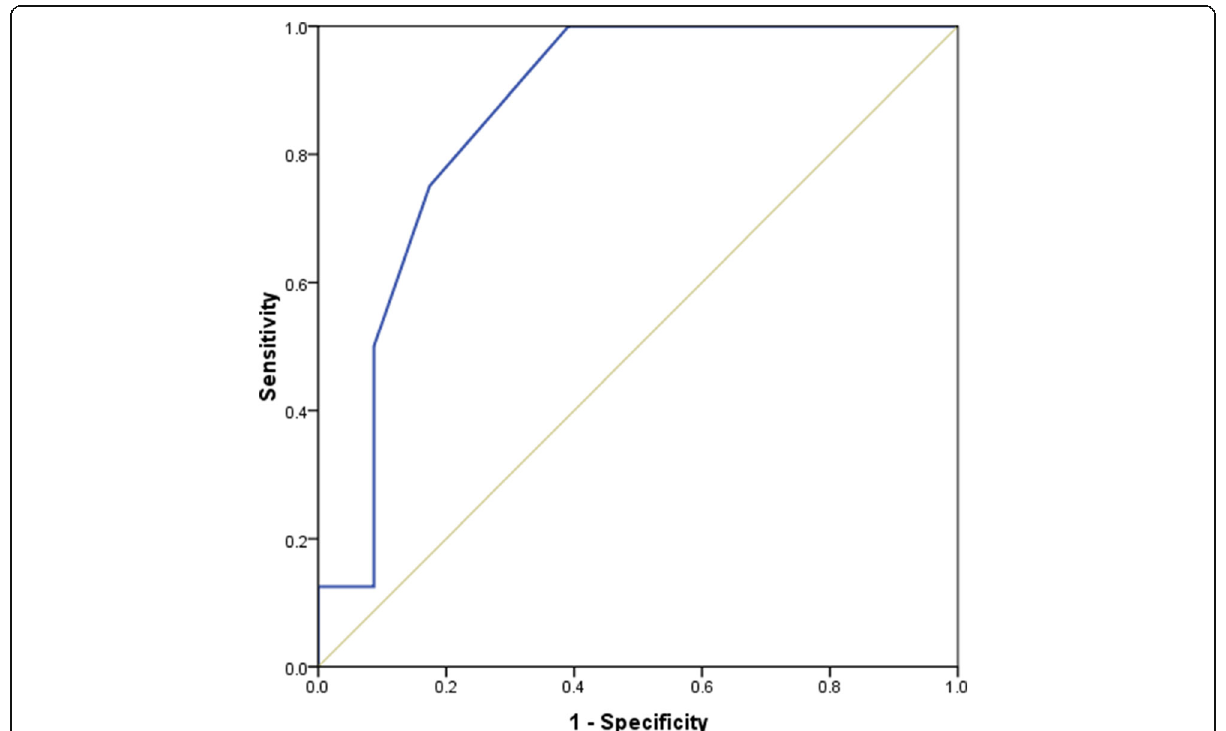
Fig. 2 ROC curve for the performance SDI in prediction of MRI changes. ROC curve analysis showed that SDI ≥ 2.5 can significantly predict MRI changes in SLE patients with headache with 75% sensitivity, 82.6% specificity, 60% PPV, and 90.5% NPV; AUC (95%CI) = 0.864 (0.74 – 0.99). SDI, SLE International Collaborating Clinics/American College of Rheumatology Damage Index; MRI, magnetic resonance imaging; PPV, positive predictive value; NPV, negative predictive value; AUC, area under the ROC